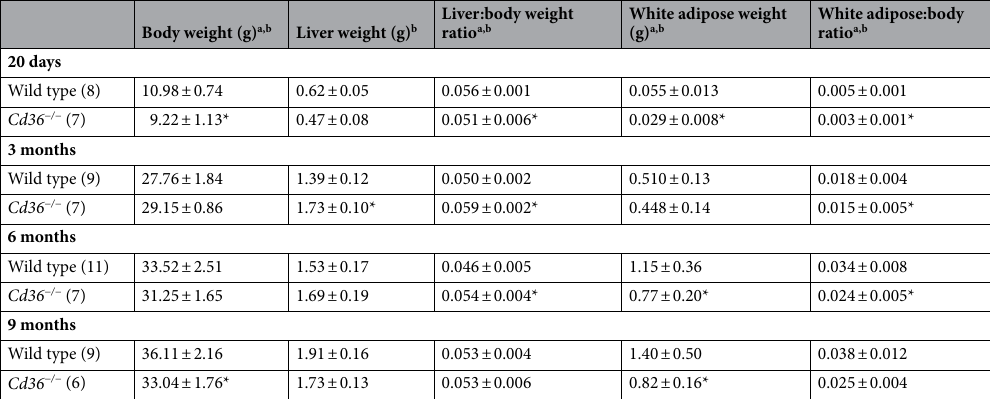
Table 1. Physical characteristics of WT and Cd36 −/− mice throughout their lifespan. The n number for each experimental group is provided in parentheses in the first column. All data are presented as mean ± SD. Data analyzed by two-way ANOVA. *Post-test significantly different between genotypes within mice of the same age. a Significant genotype effect. b Significant age